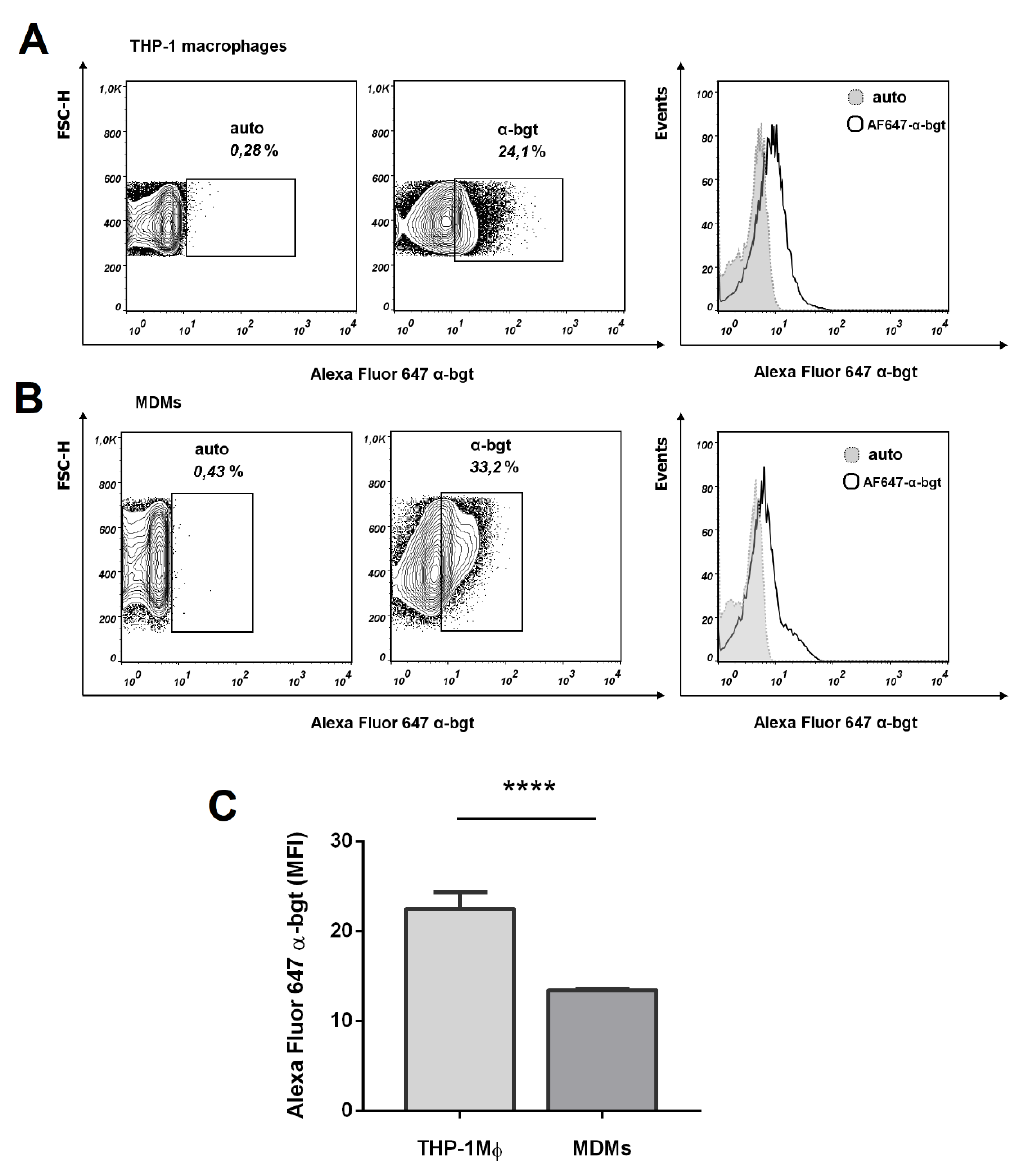
Figure 2. Expression of α 7 nAChR on the THP-1M φ and MDMs cell surface. THP-1 monocyte or primary human monocytes were di ff erentiated into macrophages (THP-1M φ and MDMs, respectively) and stained with Alexa Fluor 647-labeled alpha ( α )-bungarotoxin (AF647- α -bgt). Cell staining was analyzed by flow cytometry. ( A ) α 7 Receptor expression on the THP-1M φ or ( B ) MDMs cells is shown. Gray dotted histograms—autofluorescence of cells; black lined histograms—cells stained with AF647- α -bgt. ( C ) Intensity of AF647- α -bgt staining on THP-1M φ and MDMs. Data obtained from three independent experiments performed with MDMs from di ff erent donors. Student’s t -test: *** p <